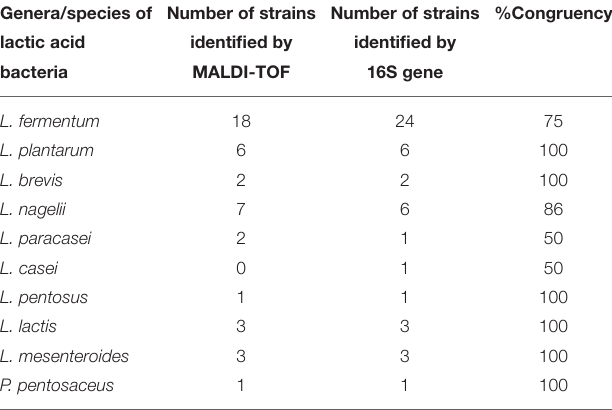
TABLE 2 | Number of identified lactic acid species from fruit pulp processing byproducts according to each applied identification technique and congruency of identification between the applied identification